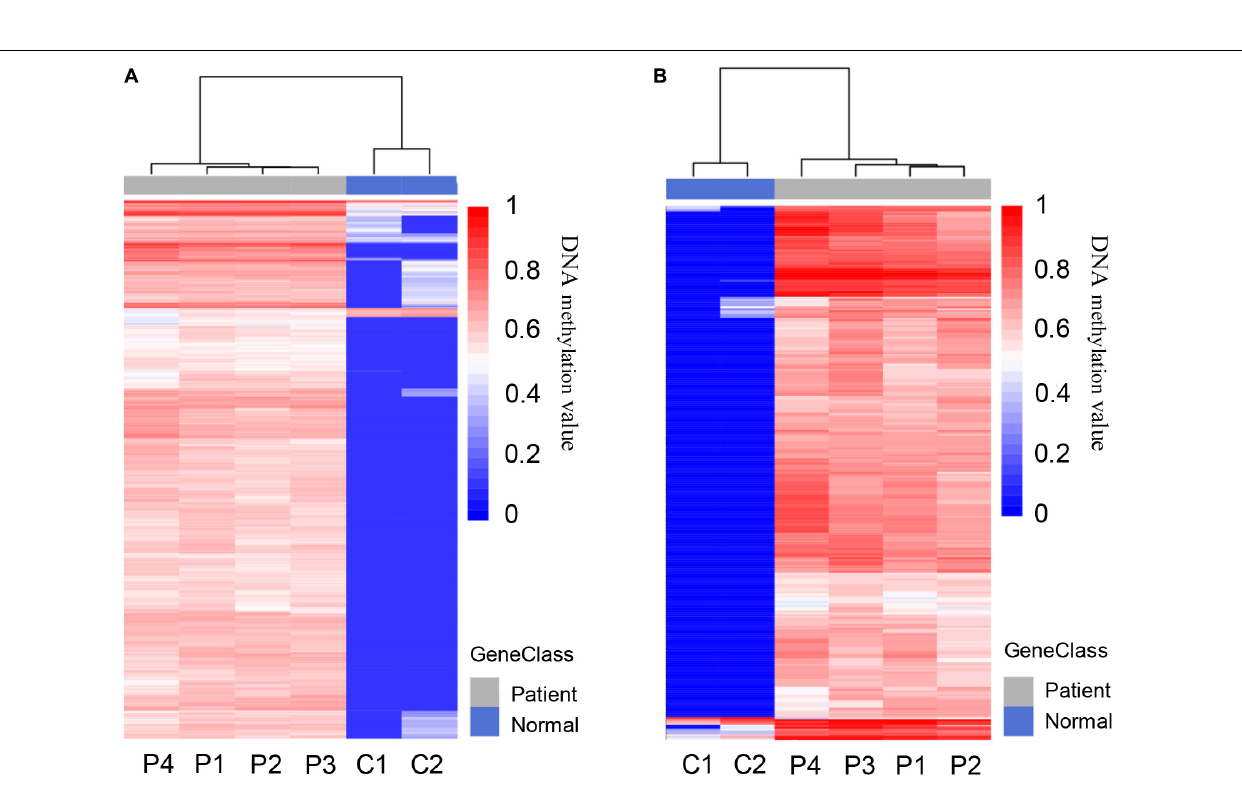
Frontiers in Genetics |